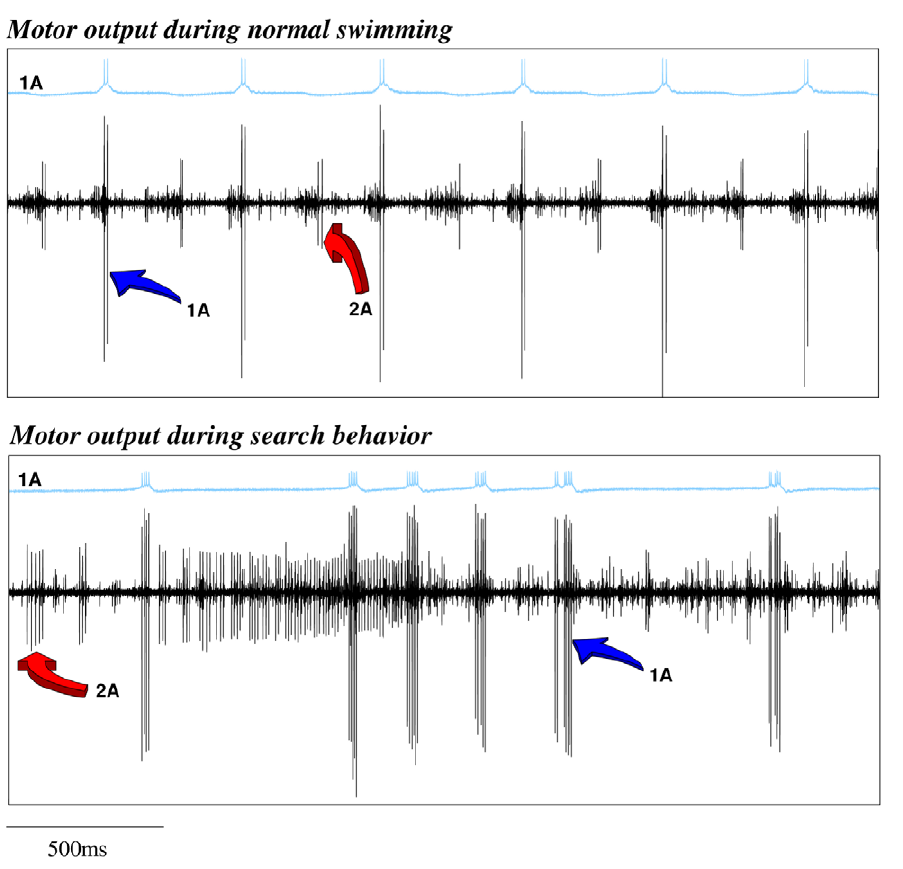
Figure 6. The behavior of the biological wing CPG. The wing CPG generates the rhythm that controls the wing movements. Each panel of the figure displays intracellular recordings of the 1A neuron (blue traces) and the extracellular activity of the wing nerve (black traces) during the two behavioral contexts: routing swimming (top panel) and search hunting (bottom panel). The arrows in the extracellular traces point out the activity associated with the firing of the 1A and the 2A cells. 1A and 2A neurons have been reported to fire doublets as well as single spikes depending on the strength of the swimming.